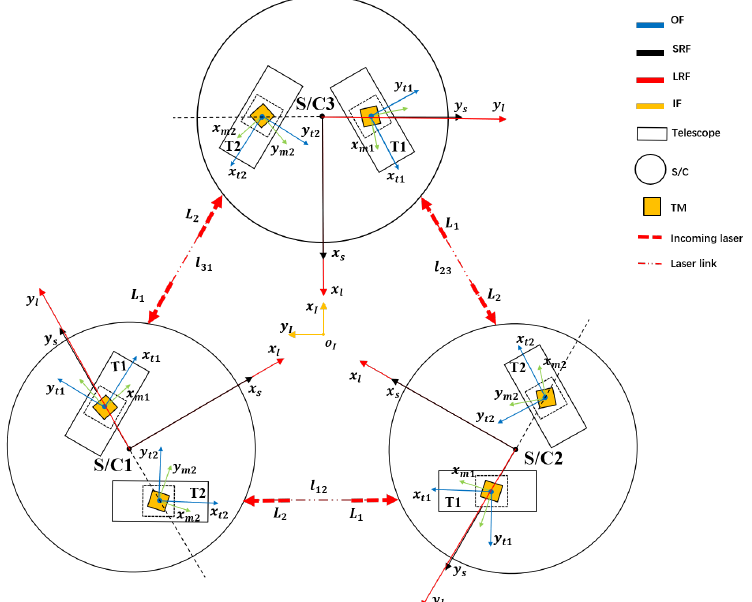
Figure 1. LOS tracking scheme. The spacecrafts point at each other to maintain accurate laser link transmission and reception. The structures of the spacecrafts S/C1, S/C2, and S/C3 are the same, and the phase angle basically differs by 120° [12]. The three spacecrafts receive and transmit lasers to form an interference arm. l ij is the arm length between S/C i and S/C j . L1 and L2 respectively represent the incident laser of a remote spacecraft received by telescopes T1 and T2. The telescope is fixed to the spacecraft, and the optical platform is fixed to the telescope. The test mass is denoted as TM, which is located in the cage. The cage is shown as a dotted-line box. The test mass in the telescope floats freely in the direction of the sensitive axis. OF, SRF, LRF, and IF represent the optical assembly frame, S/C rotation reference frame, LOS reference frame, and inertial frame, respectively.